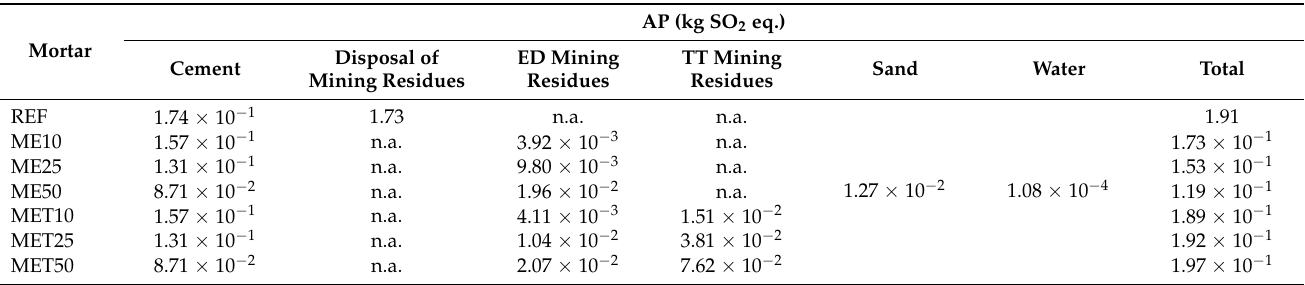
Table A5. Environmental impacts in the Acidification Potential category, from the production of 1 t of mortars with cement and treated mining residues as binder constituents.